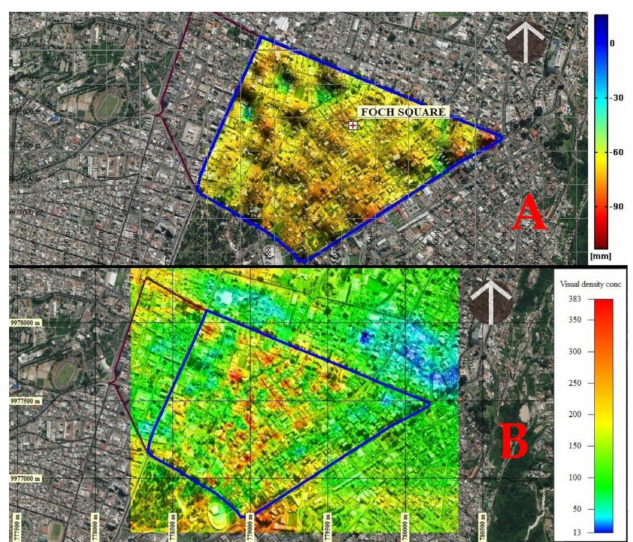
Figure 9. ( A ) Results of cumulative displacement obtained from INSAR, 2015–2019 period. In ( B ) Visual integration in the sector. The colors towards the red represent ground lift and in blue subsidence on the accumulated displacement map. Colors with a tendency towards red represent greater visibility on the vsisibiity intensity map. Graphical scale